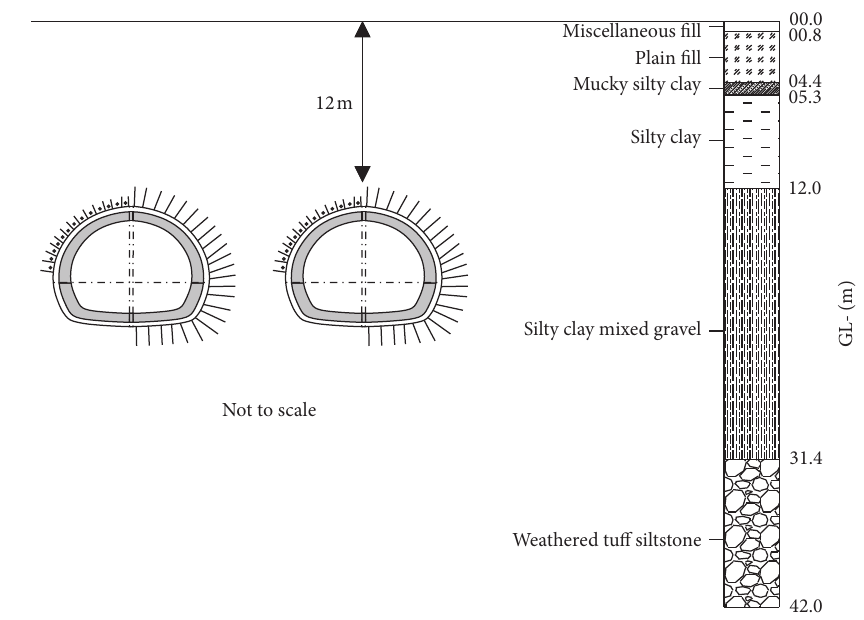
Figure 5: Typical transverse profile (not to